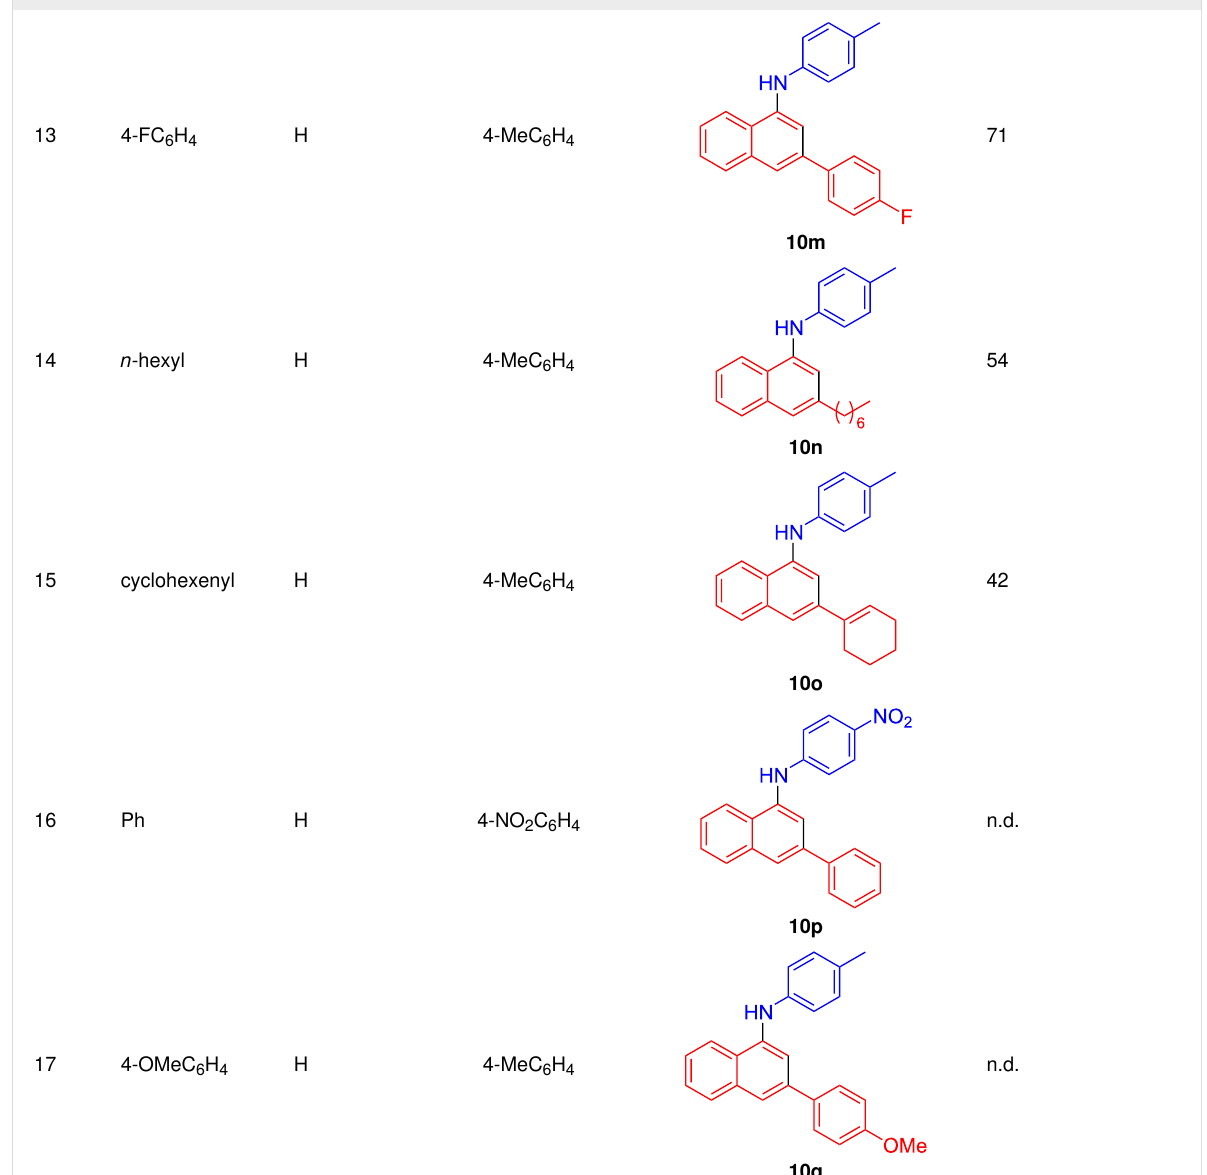
Table 5: LS-FAS-Cu catalyzed synthesis of aminonaphthalene derivatives. a